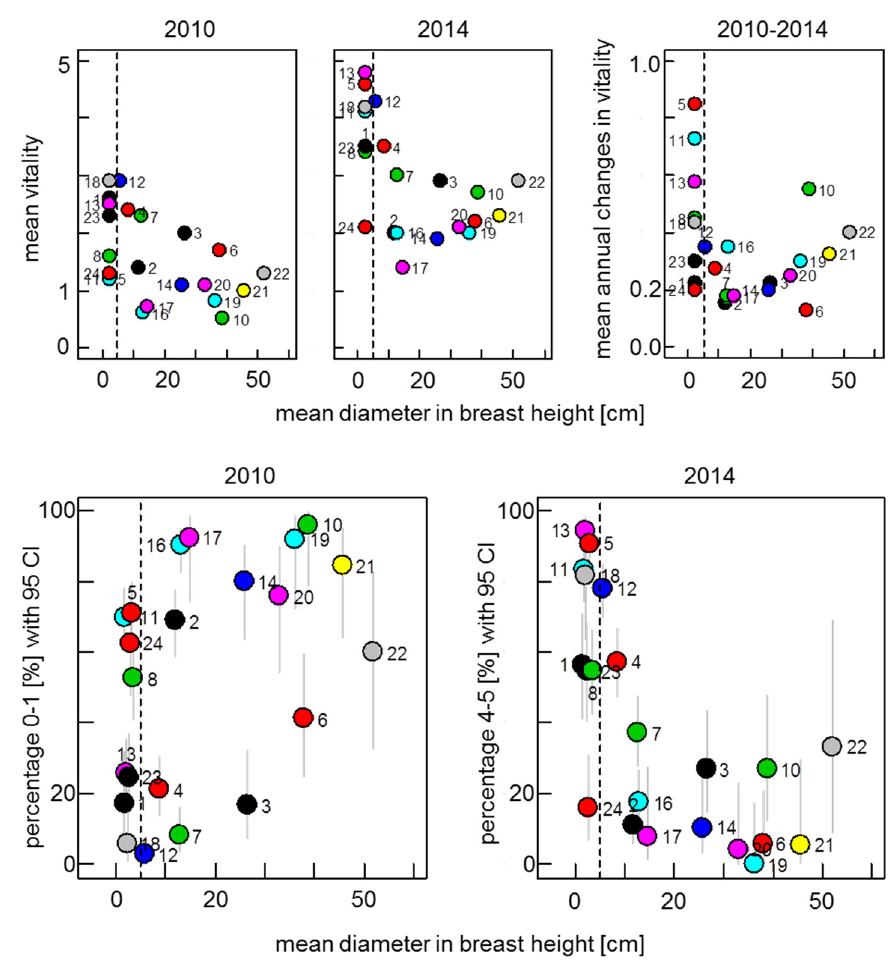
Figure 3. The mean vitality per stand in relation to the mean diameter at breast height (DBH) is illustrated for the years 2010 and 2014. As all the young growth stands were under a DBH of 5 cm, they were set to a DBH of 2.5 cm for illustration. The mean annual changes in vitality over the years from 2010 to 2014 in relation to the DBH are shown on the right site. At the bottom row, the percentage with 95% confidence interval of trees of the vitality class 0 and 1 for 2010 and of the vitality class 4 and 5 for 2014 in relation to the DBH is shown. Numbers indicate study sites (Table 1).